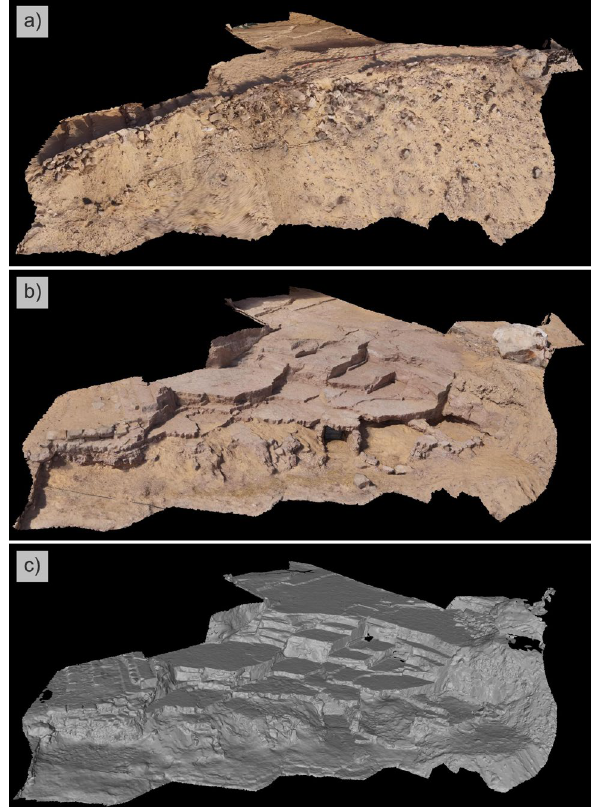
Figure 5. 3D models obtained: a) 2017 from CRP; b) 2019 from CRP; c) 2019 from TLS.